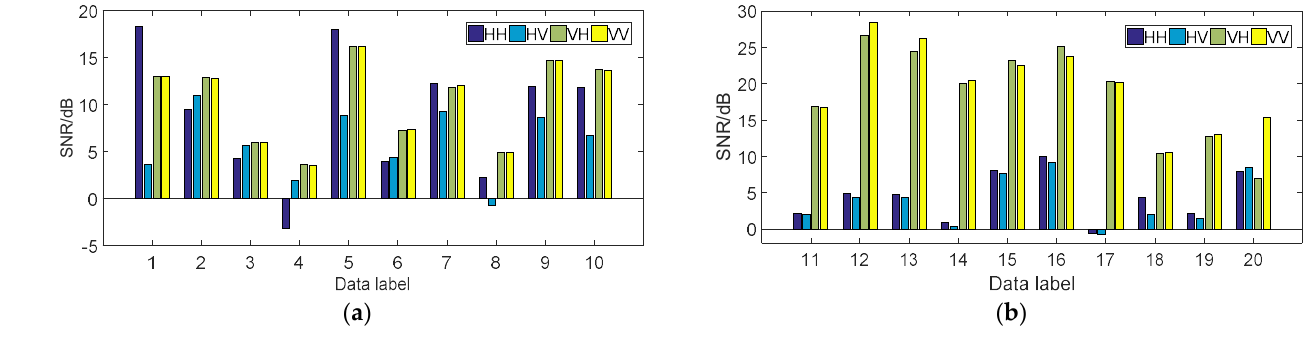
Figure 12. Statistical results of data signal-to-noise ratio. ( a ) IPIX-1993. ( b ) IPIX-1998.